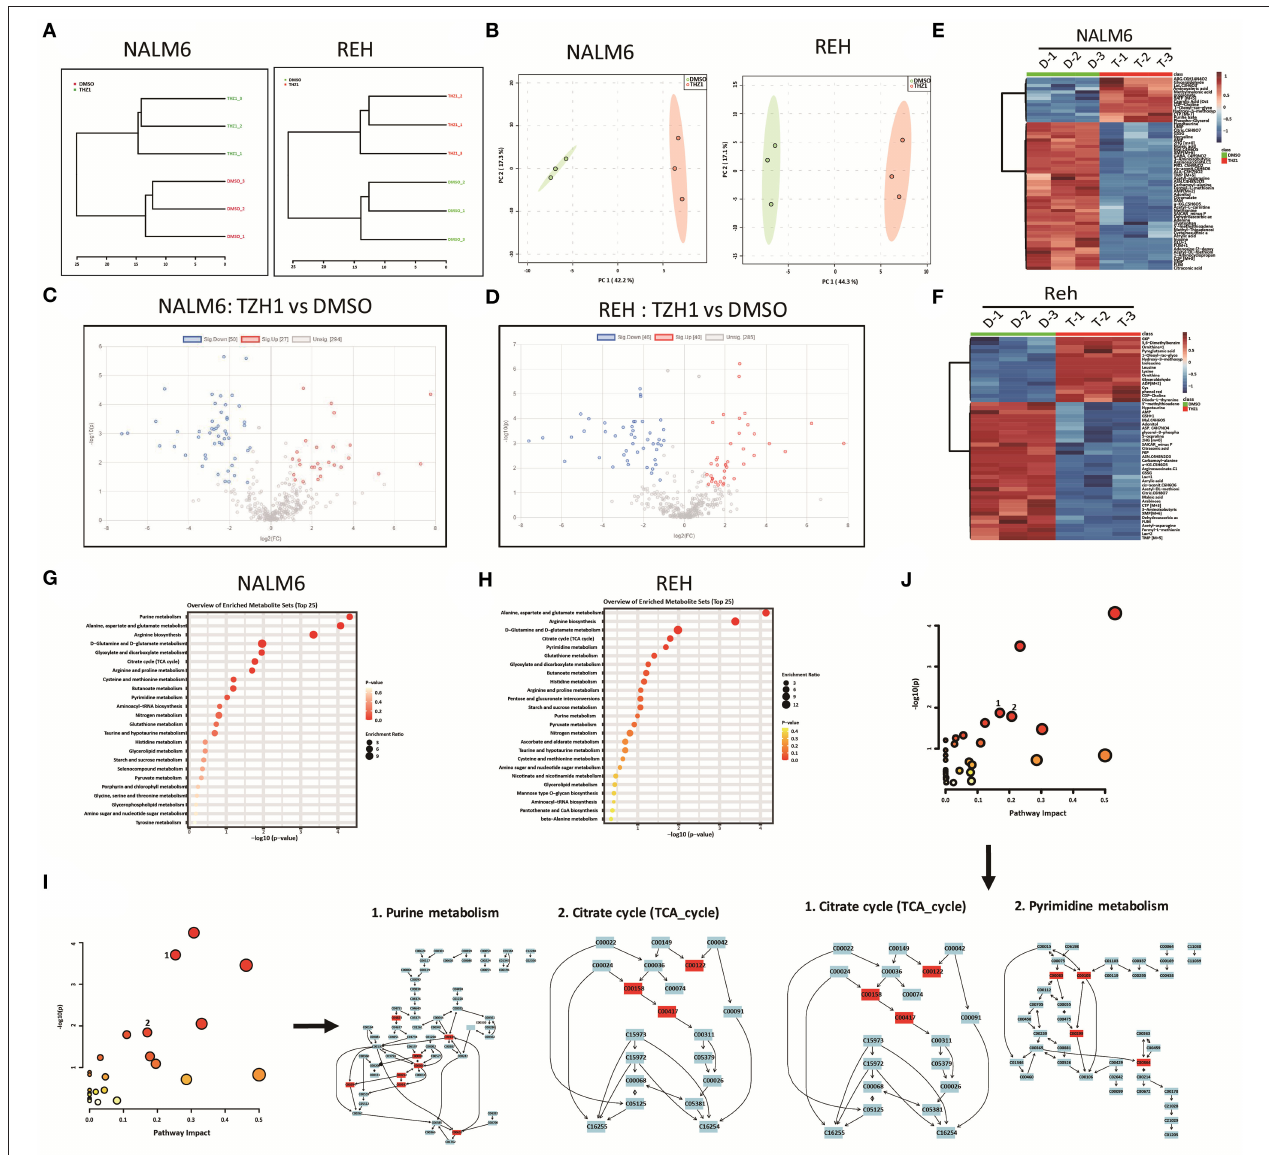
FIGURE 5 | THZ1 blocks the production of metabolic intermediates in B-ALL cells. (A,B) Correlation analysis and principal component analysis of the metabonomic data in THZ1- and DMSO-treated NALM6 and REH cells. (C,D) Volcano plot of differentially metabolic intermediates by a log2-fold change ≥ 1.0 or ≤ − 1.0 ( p < 0.05) in THZ1- and DMSO-treated NALM6 and REH cells. (E,F) Heatmap of differentially metabolic intermediates by a log2-fold change ≥ 1.0 or ≤ − 1.0 ( p < 0.05) in THZ1- and DMSO-treated NALM6 and REH cells. (G,H) Pathway analysis of upregulated and downregulated metabolic intermediates ( p < 0.05) in THZ1- and DMSO-treated NALM6 and REH cells. (I,J) Pathway analysis of downregulated metabolic intermediates ( p < 0.05) in THZ1- and DMSO-treated NALM6 and REH cells. B-ALL cells were treated with THZ1 for